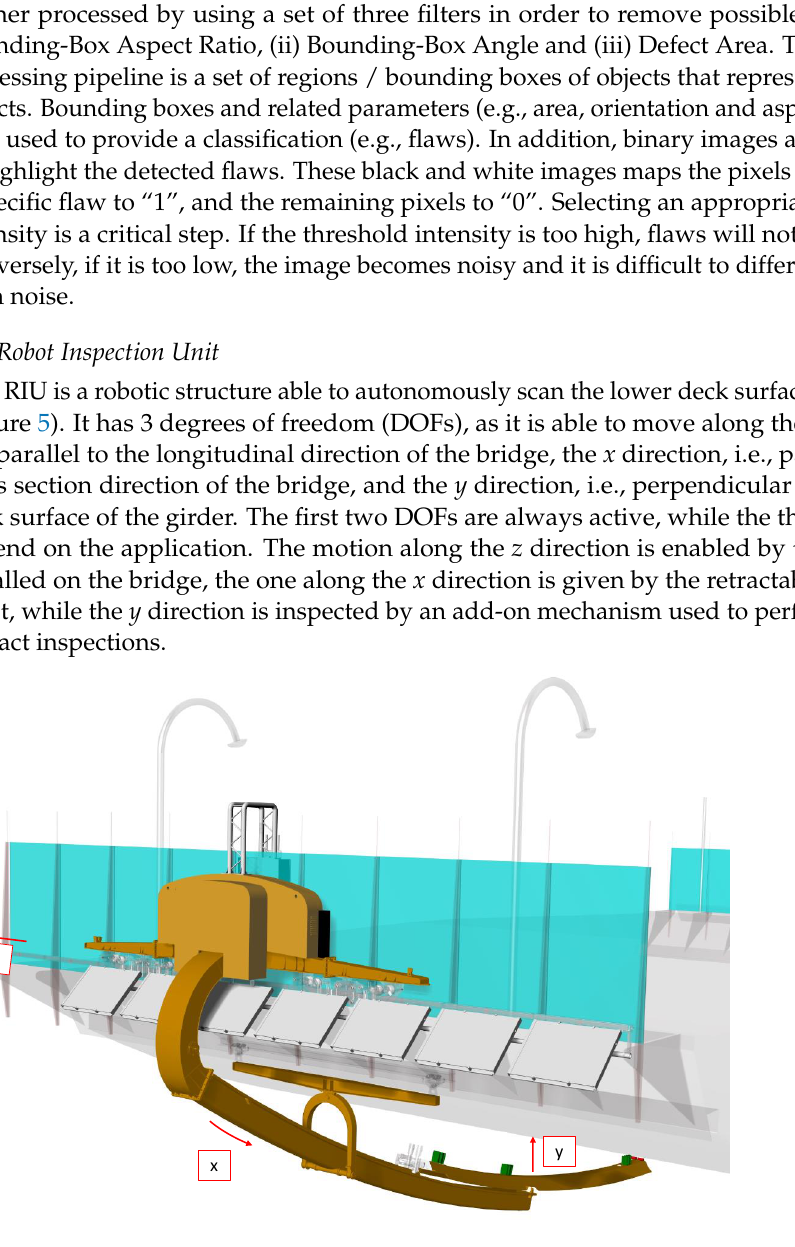
Figure 5. Representation of Robot Inspection Unit (RIU), with the three directions of the motion labeled with red